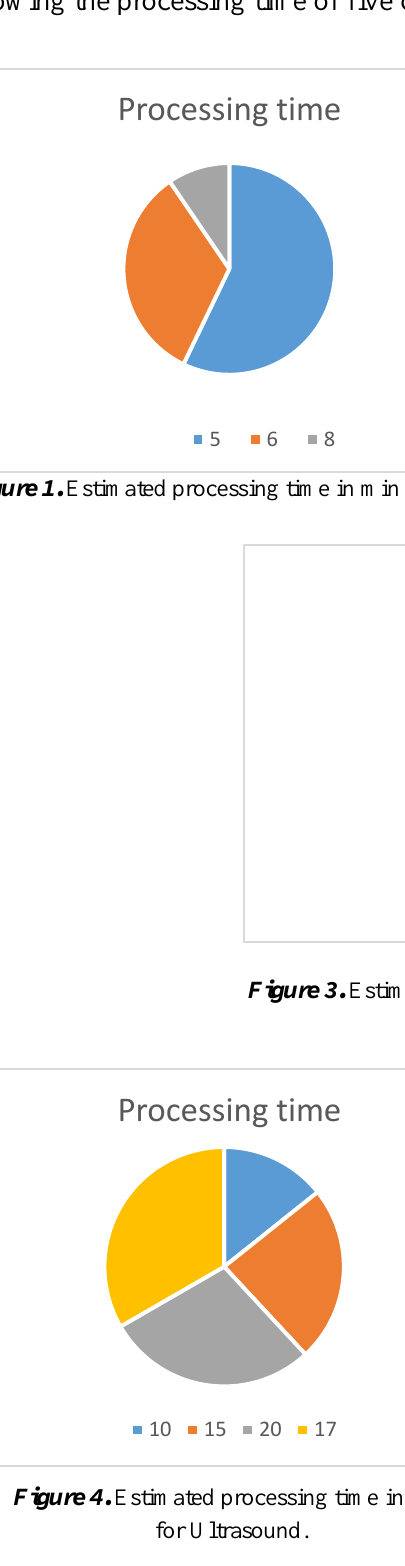
Figure 4. Estimated processing time in min for Ultrasound.